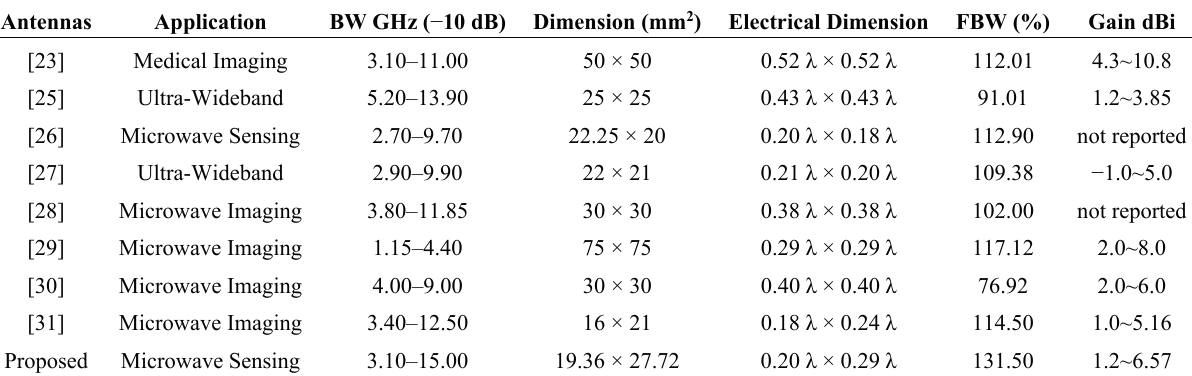
Figure 19. The radiation efficiency of the reported UWB antenna. Table 4. Comparisons between the proposed UWB antenna and existing